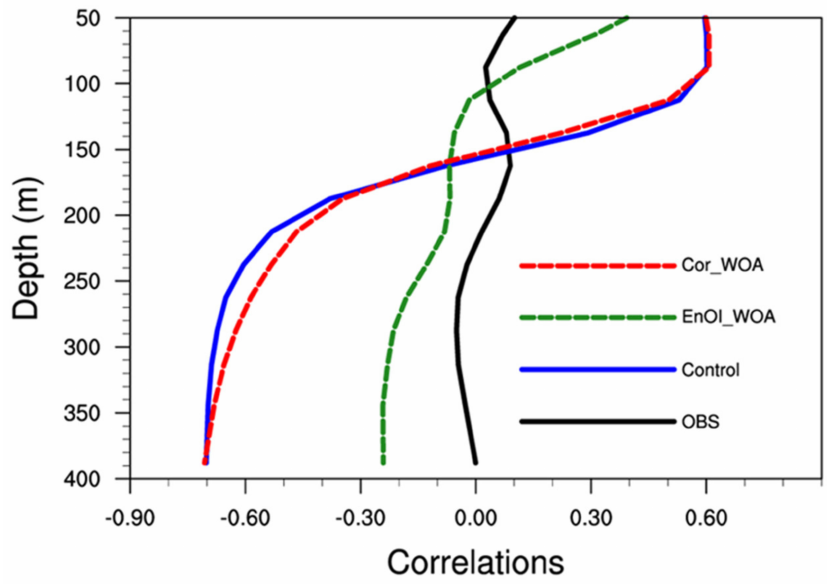
Figure 6. The correlation between SST and the upper 400 m horizontal current in the western tropical Pacific: black solid line, OBS; blue solid line, Control; green dashed line, EnOI_WOA; red dashed line,